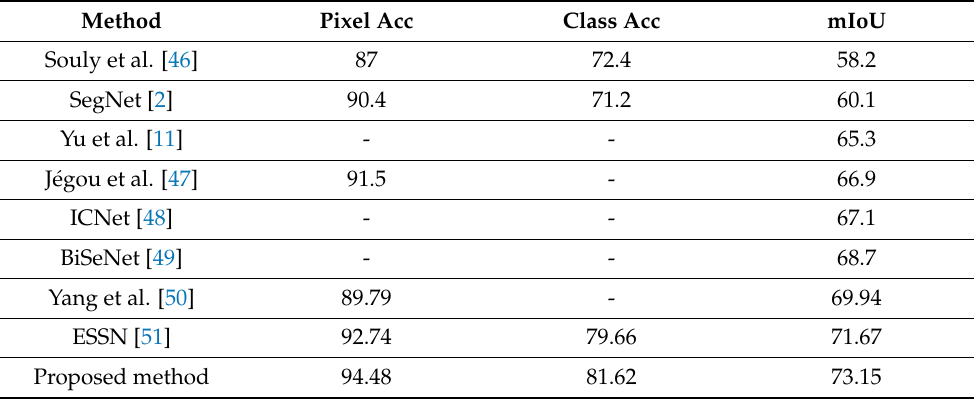
Table 6. Comparisons of the proposed method with state-of-the-art methods (unit: %).